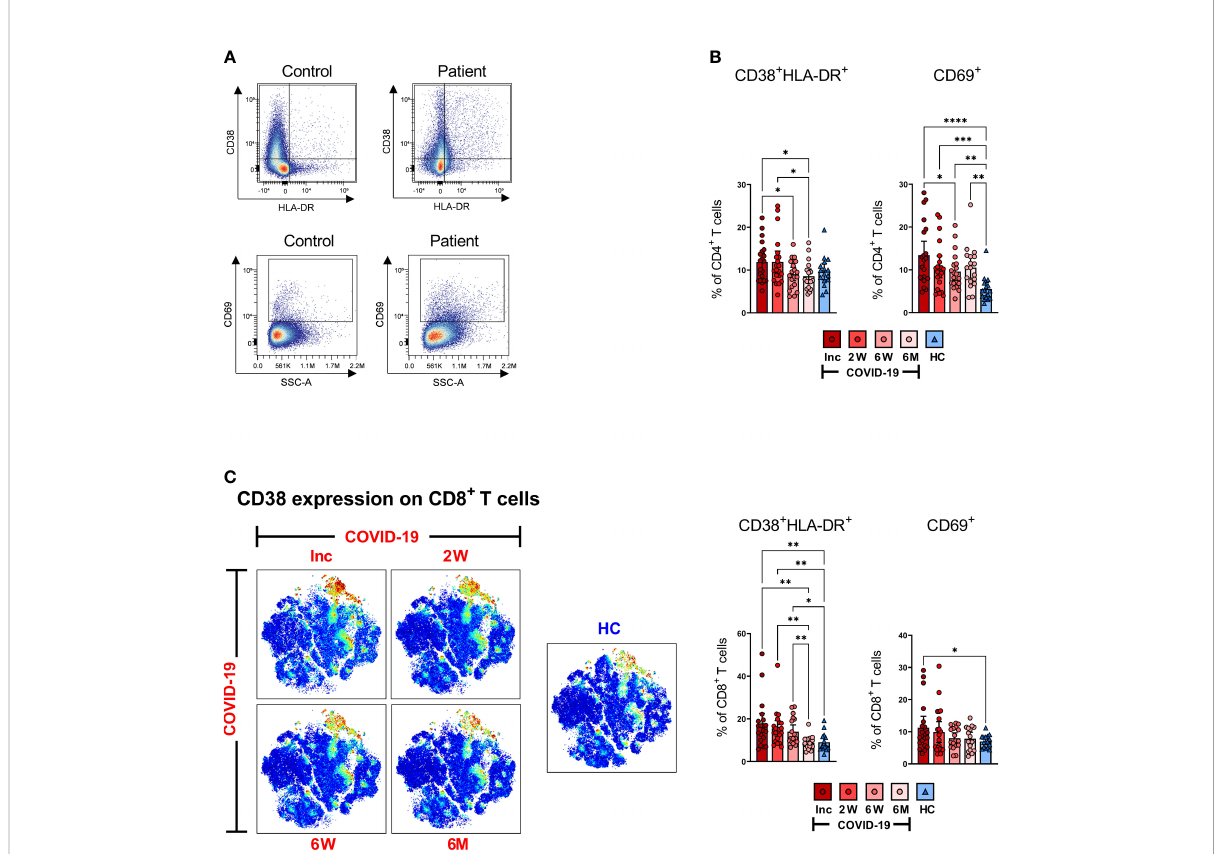
FIGURE 4 T cells are activated during SARS-CoV-2 infection. PBMCs collected from COVID-19 patients that required hospitalization (N=23) and healthy donors (N=16), were stained for fl ow cytometry to assess the activation status of CD4 + and CD8 + T cells. (A) Representative dot plots for CD38 + HLA-DR + and CD69 + activated CD4 + and CD8 + T cells. (B) Proportions of the CD38 + HLA-DR + and CD69 + activated CD4 + T cells. (C) tSNE plots displaying CD8 + CD3 + cells, colored according to intensity of CD38 expression, as well as proportions of the CD38 + HLA-DR + and CD69 activated CD8 + T cells. Data is represented as mean with 95% Cl, with signi fi cance of *p ≤ 0.05, **p ≤ 0.01, ***p ≤ 0.001, ****p ≤ 0.0001, determined using Brown-Forsythe and Welch ANOVA tests. Inc = Inclusion in study at the hospital, 2W = 2 weeks, 6W = 6 weeks, 6M = 6-7 months, HC = healthy